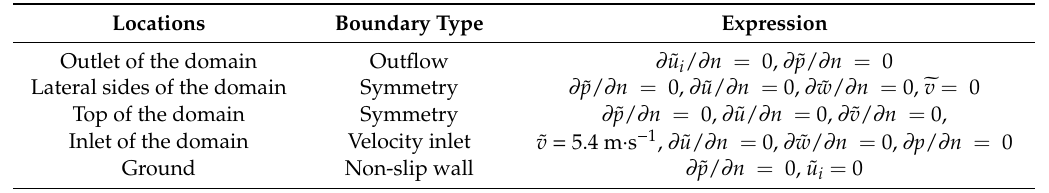
Table 2. Settings of the boundary conditions.